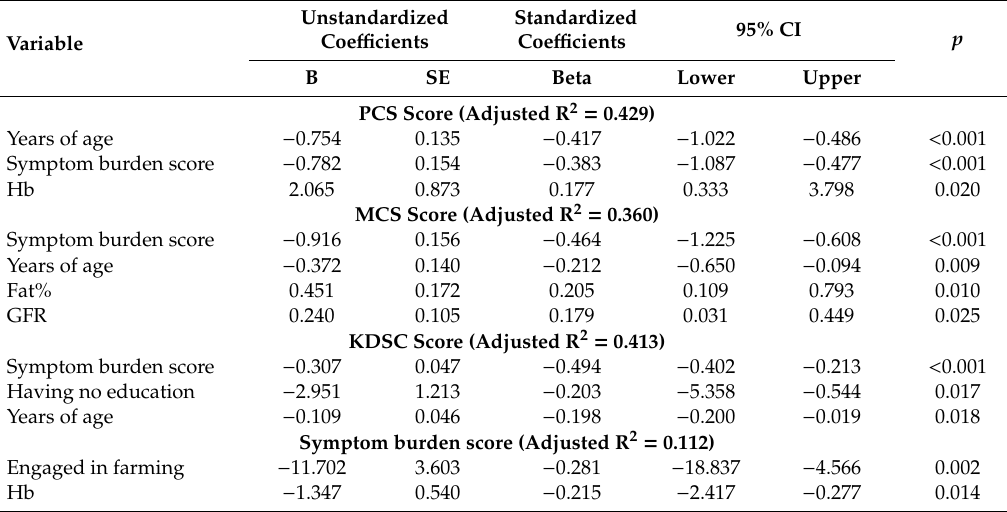
Table 6. Stepwise multiple regression analysis of independent variables with PCS, MCS, KDSC, and symptom burden